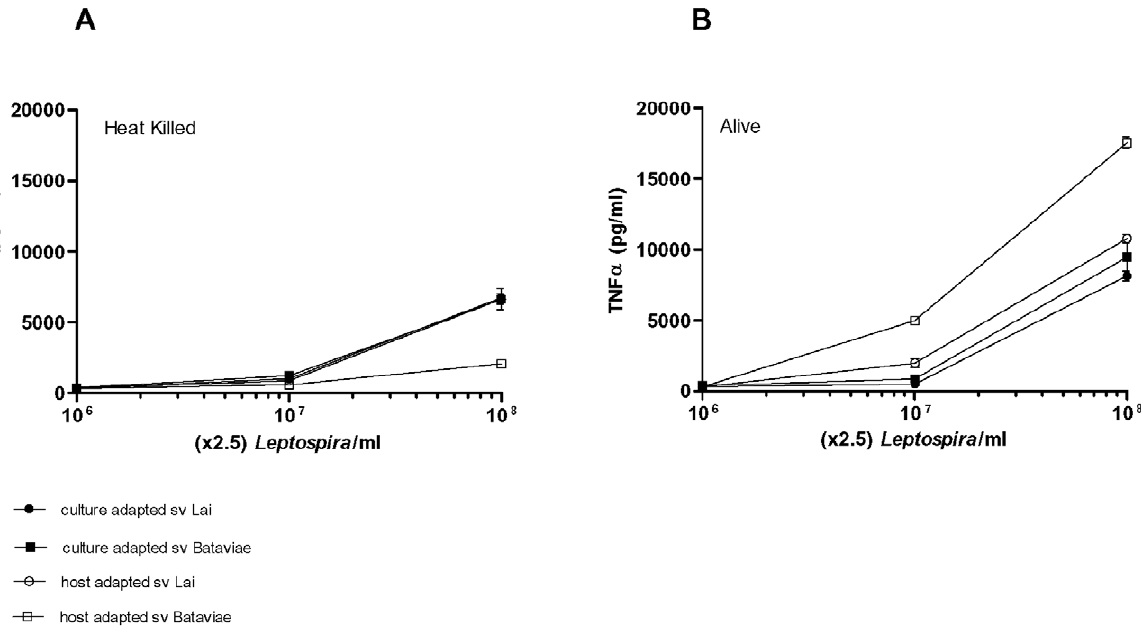
Figure 2. Activation of THP-1 cells with heat-killed and live leptospires. Cells were stimulated for 6 h with varying concentrations of leptospires. TNF- a concentrations were measured from cell culture supernatants. Data represent the mean values of quadruplicate experiments. Error bars represent the standard deviation (SD) of the mean. Panel A: Heat killed leptospires; panel B: Alive leptospires. The response of all blanks was below the baseline and therefore is not shown.